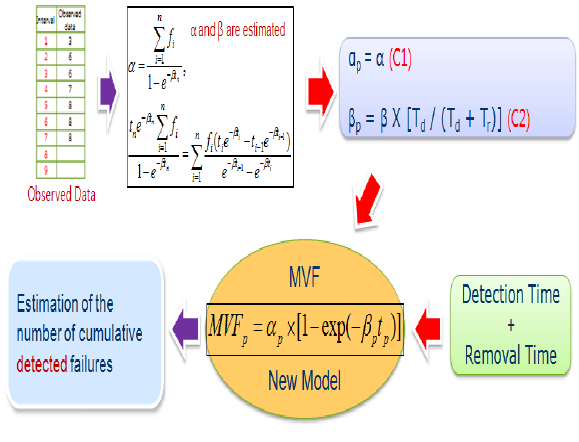
Fig. 5. Process of Proposed